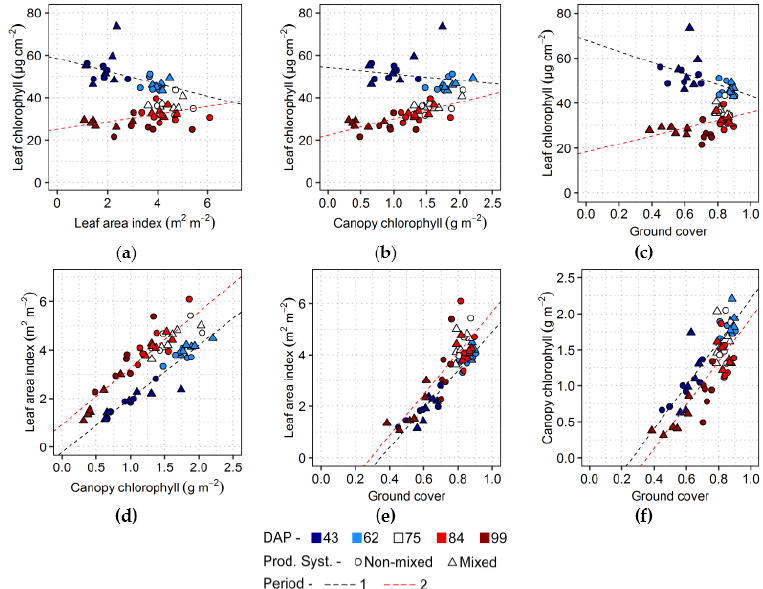
Figure 4. Pairwise comparison of crop traits measured over the season (from 43 to 99 DAP): ( a ) Leaf chlorophyll content and leaf area index, ( b ) Leaf chlorophyll content and canopy chlorophyll, ( c ) Leaf chlorophyll content and ground cover, ( d ) Leaf area index and canopy chlorophyll, ( e ) Leaf